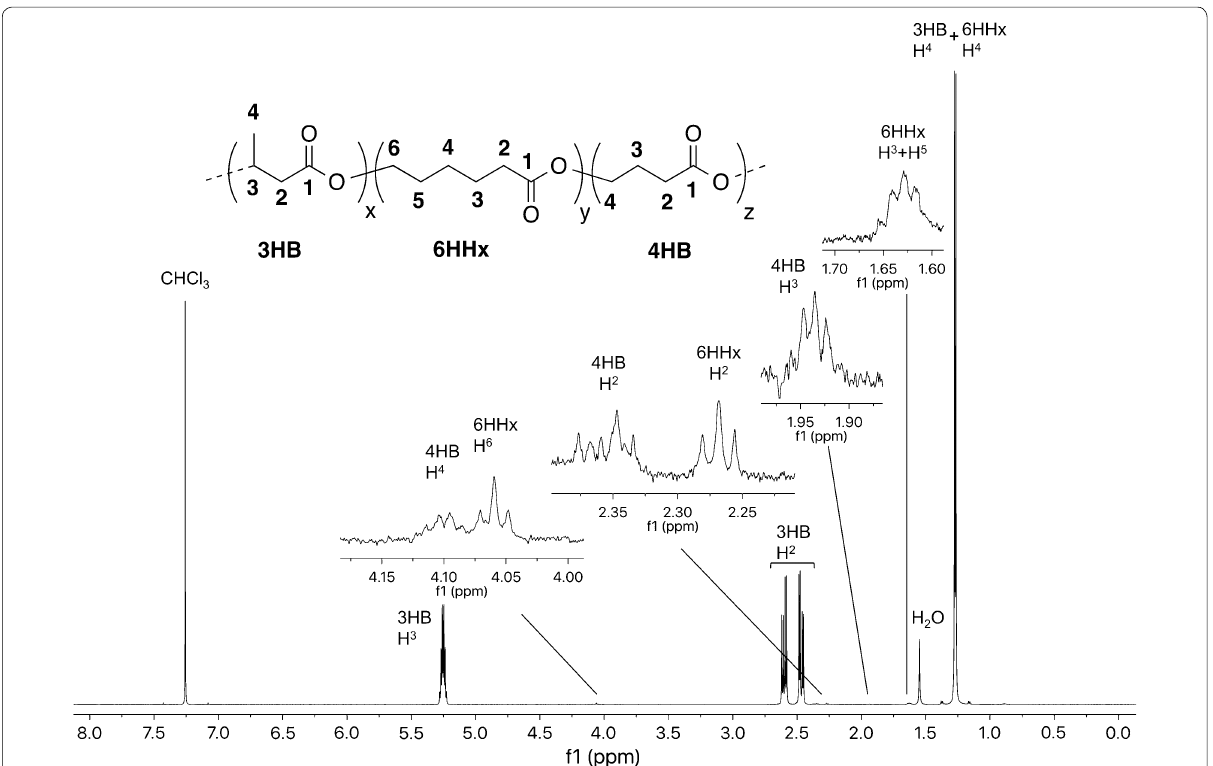
Fig. 3 1 H-NMR spectrum of P(3HB- co -6HHx- co -4HB) produced by M. parvus OBBP